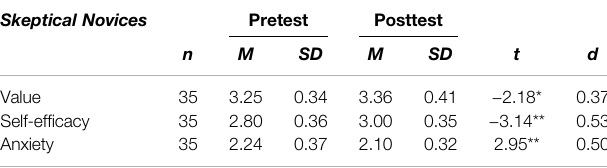
TABLE 6 | Pretest and posttest scores of the skeptical novices for the three measures value, self-ef fi cacy and anxiety, and t -test for difference in means. Skeptical Novices Pretest